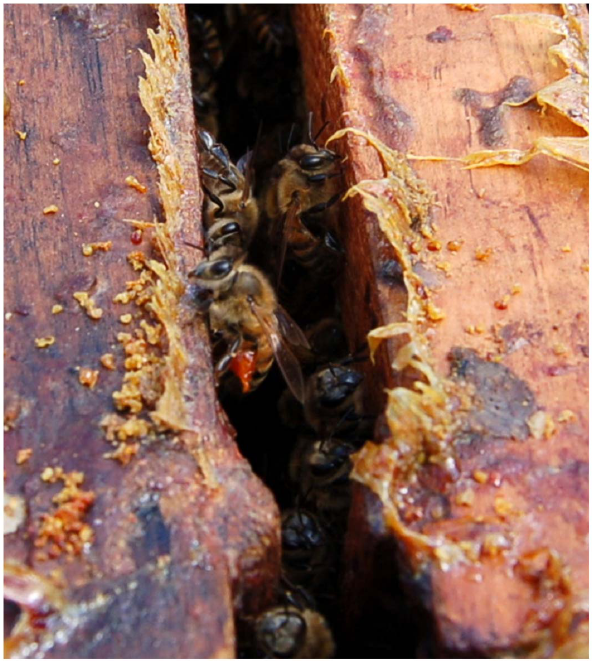
Figure 1. Honey bee resin collection. Top-down view of standard beekeeping equipment displaying a resin forager with red resin attached to her hind legs. Managed honey bees deposit resin mainly at the hive entrance, inner cover, and on top of the movable frames.